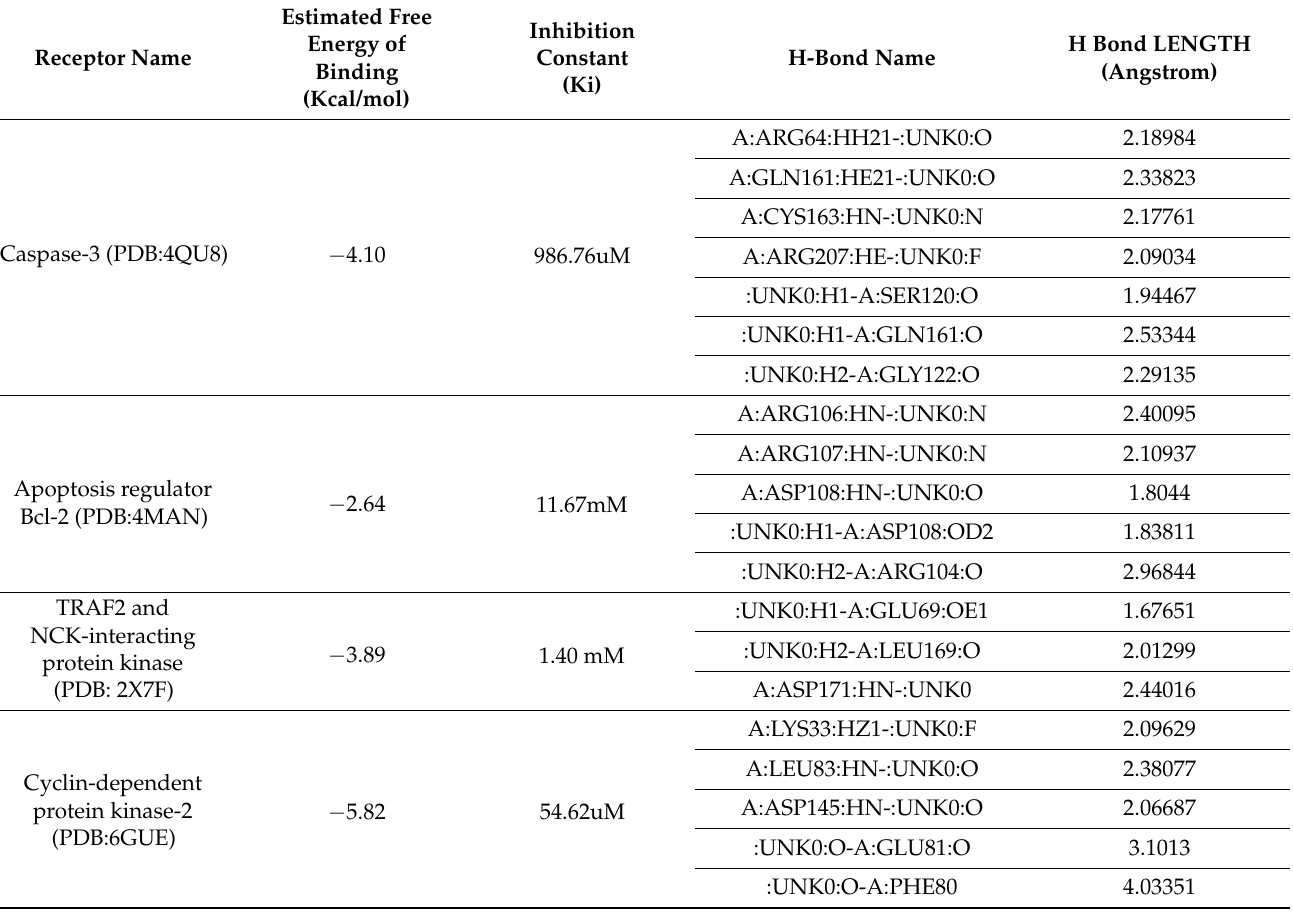
Table 3. Showing docking results of anti-cancerous drug fluorouracil with receptor molecules caspase- 3, apoptosis regulator Bcl-2, TRAF2 and NCK-interacting protein kinase and cyclin-dependent protein kinase-2.